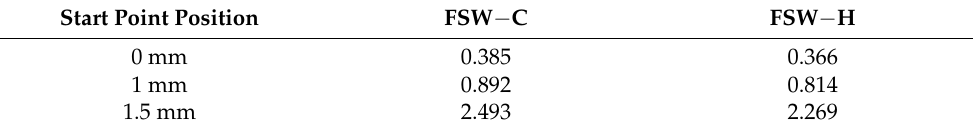
Table 4. “Pseudo strain”